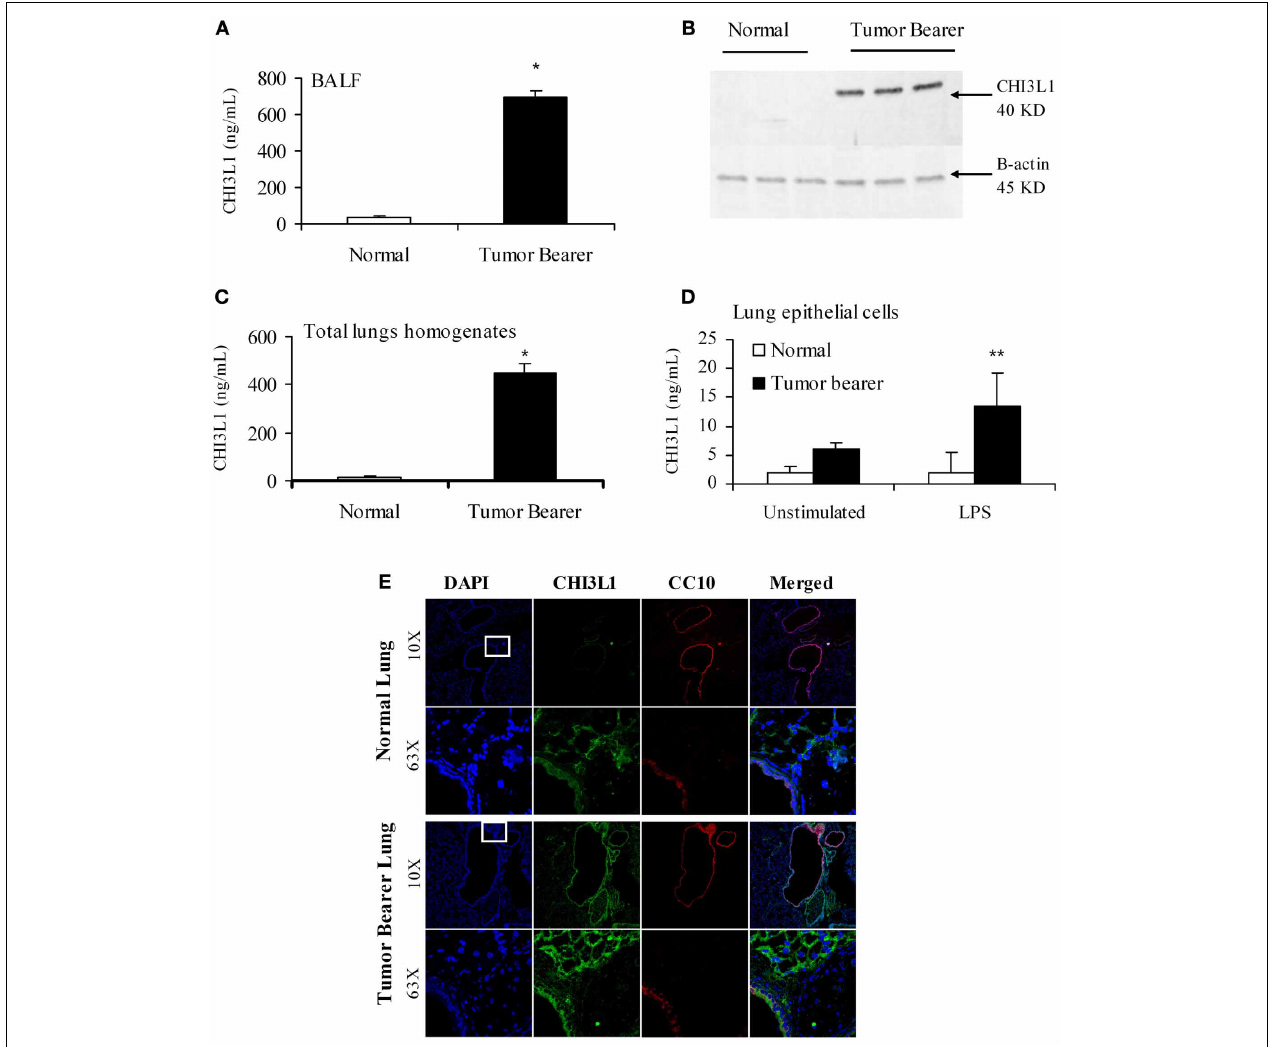
FIGURE 2 | CHI3L1 is expressed at higher levels in the pulmonary tissue of 2-week 4T1 mammary tumor bearers. (A) CHI3L1 expression in bronchoalveolar lavage fluid by ELISA; (B) Western blot analysis of total lung homogenates for CHI3L1 expression; ( C,D ) CHI3L1 expression by ELISA of